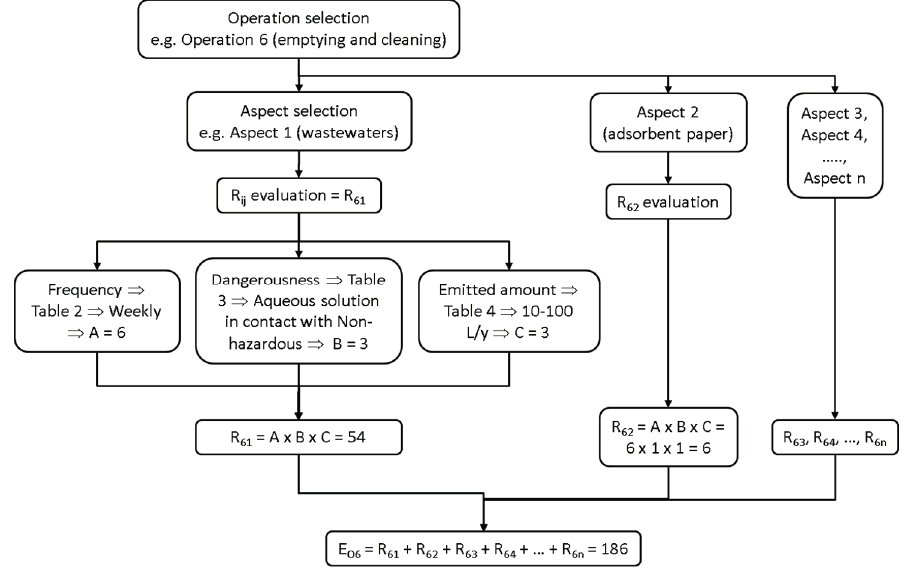
Figure 1. Evaluation of Environmental Risk Index: Schematic